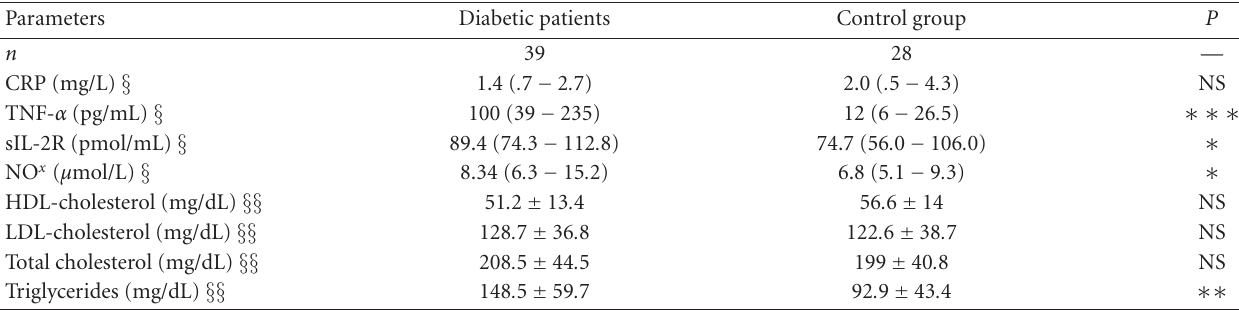
Table 3: Serum concentrations of the studied parameters. n = number of subjects, TNF- α = tumour necrosis factor alpha, sIL-2R = soluble interleukin 2 receptor, NO x = nitric oxide metabolites, § = median (with the 25th and 75th centiles-quartiles), §§ = mean ±